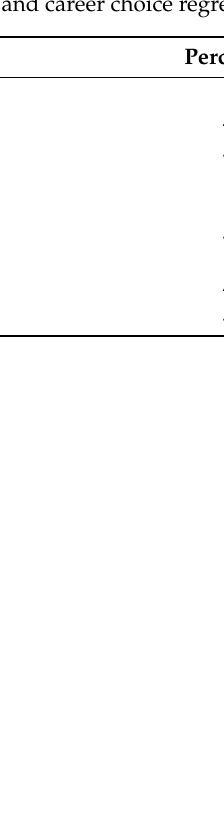
Table 2. Prevalence of job burnout, depressive symptoms, and career choice regret.